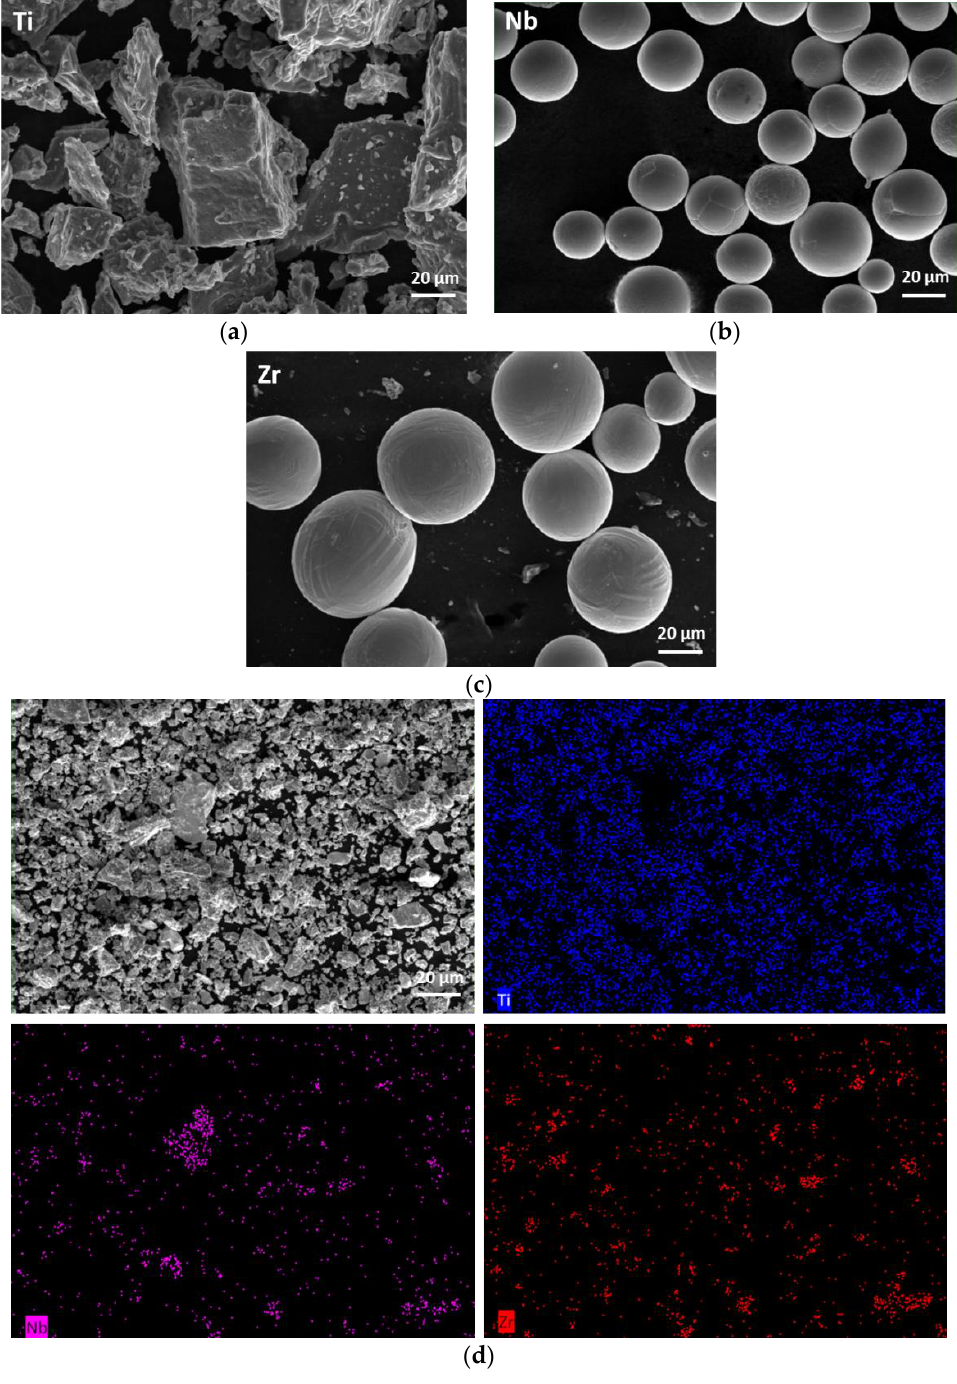
Figure 2. SEM micrographs of as-received ( a ) Ti, ( b ) Nb, and ( c ) Zr powders. ( d ) shows milled Ti-25Nb-6Zr powders.